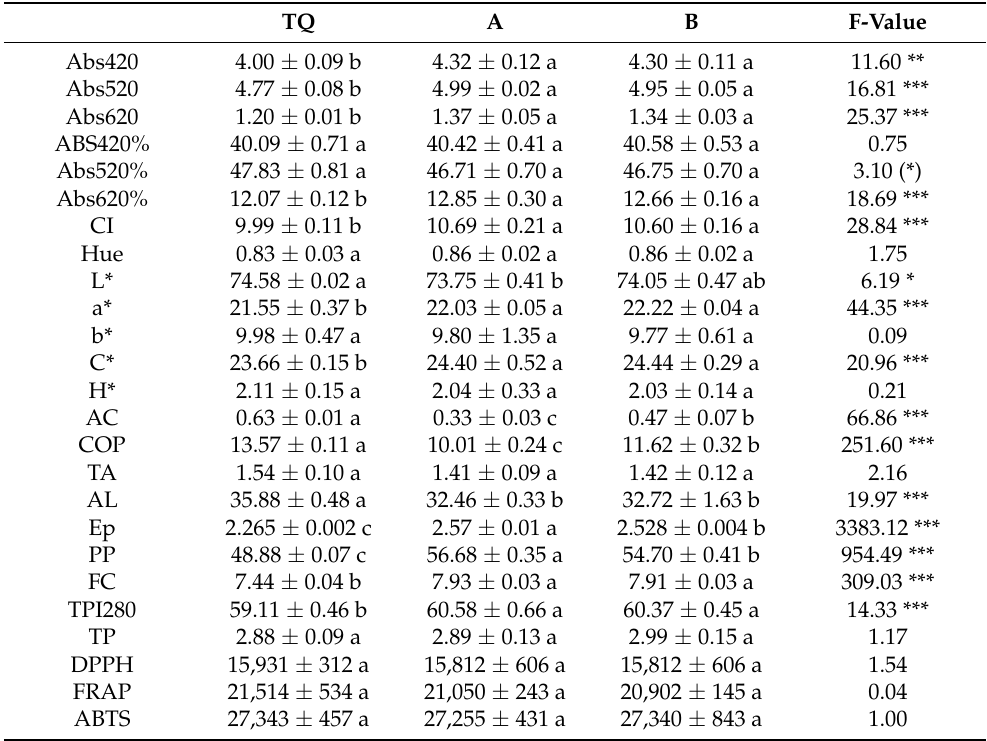
Table 2. Chemical parameters of the wine samples aged for twelve months (T12) in the presence of different stabilizing